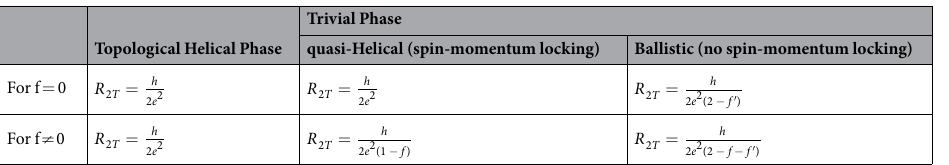
Table 4. Topological Helical vs. Trivial quasi-helical vs. Trivial Ballistic phase via 2T